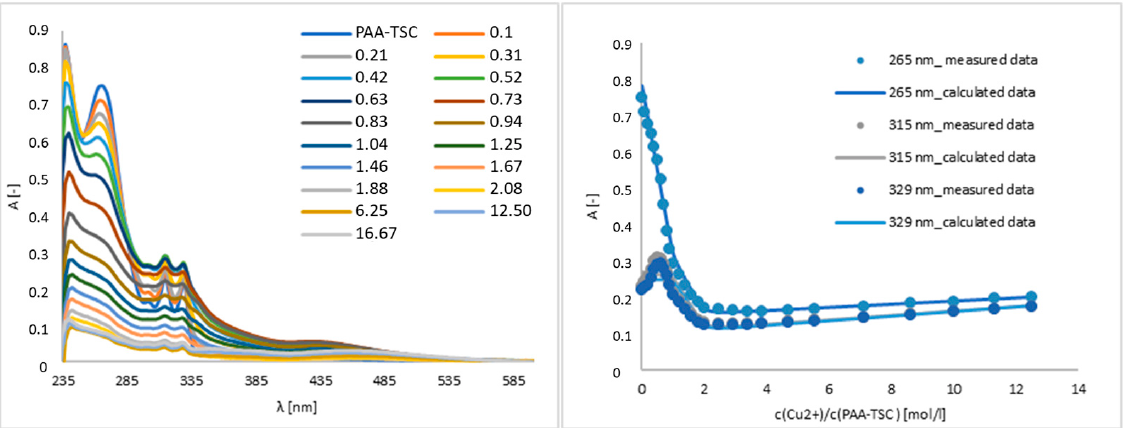
Figure 3. Titration and titration curves of the PAA-TSC receptor with Cu(II) ions in water (wa- ter/DMSO, 99:1, v / v ). Titration curves were measured at the absorption maxima (265 nm, 315 nm, 329 nm) of the PAA-TSC receptor. Table 2. Ka values and stoichiometry of receptors (PAA-TSC, T8H-TSC) in complex with metals (Cu(II), Fe(III), Fe(II)) in water (water/DMSO, 99:1, v / v